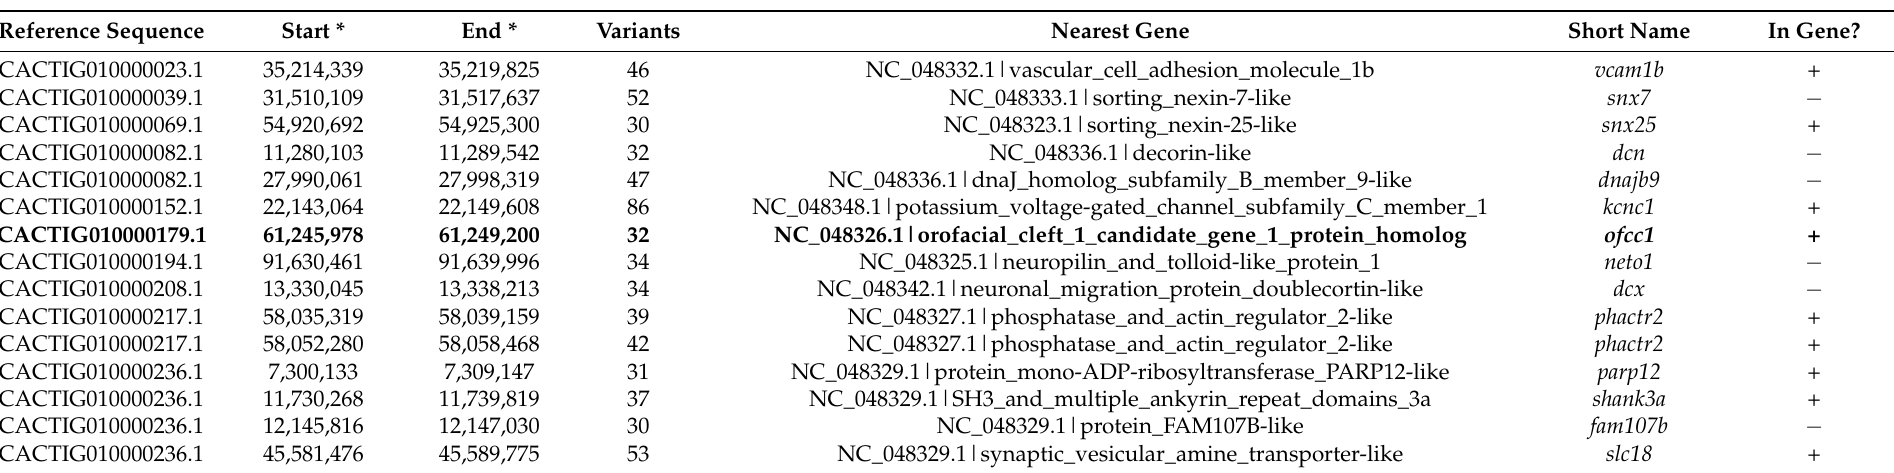
Table 1. Known and predicted genes nearest to the top 15 sex-variable variant clusters identified using AG WGS reads and AR female reference genome. ofcc1 , the gene nearest to the previously reported sex-variable region, is in bold.